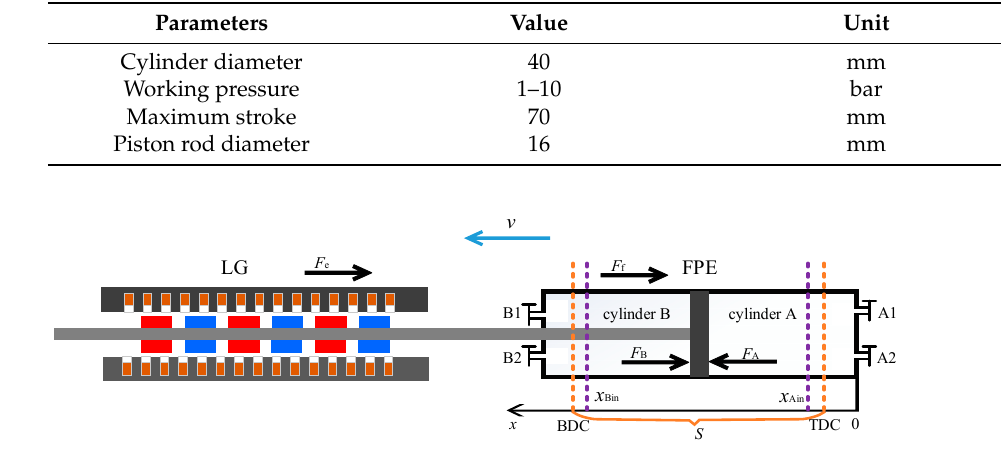
Figure 2. Schematic of the single–piston